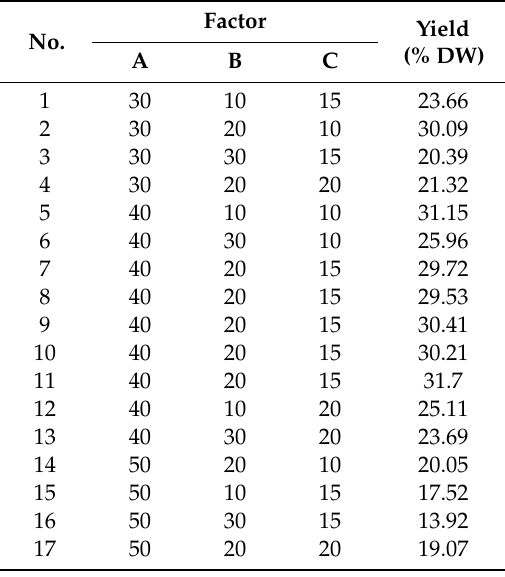
Table 4. Design and results of Box-Behnken